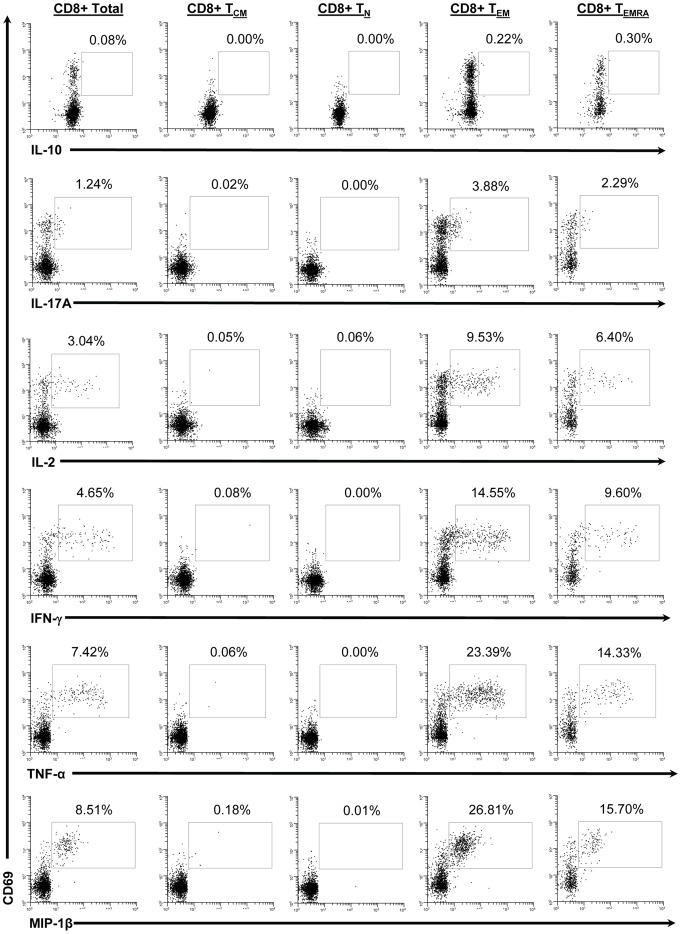
Detection of intracellular cytokines/chemokines produced by CD8+ T cell memory subsets in response to stimulation with S. Typhi-infected autologous B-LCL.Histograms from a representative volunteer (53 s at day 7 post infection) showing the production of 6 cytokines/chemokines by memory T cell subsets following stimulation with S. Typhi-infected autologous B-LCL. CD69 (a marker of recent activation) is displayed on the y-axis and each of the 6 cytokines/chemokines measured are displayed on the x-axes. Column 1 represents total CD8+ T cells, column 2 represents T central memory (TCM; CD62L+ CD45RA-), column 3 represents T naïve (TN; CD62L+ CD45RA+), column 4 represents T effector memory (TEM; CD62L- CD45RA-), and column 5 represents T effector memory CD45RA+ (TEMRA; CD62L- CD45RA+). The percentage of positive cells is shown for the indicated region in each cytogram.